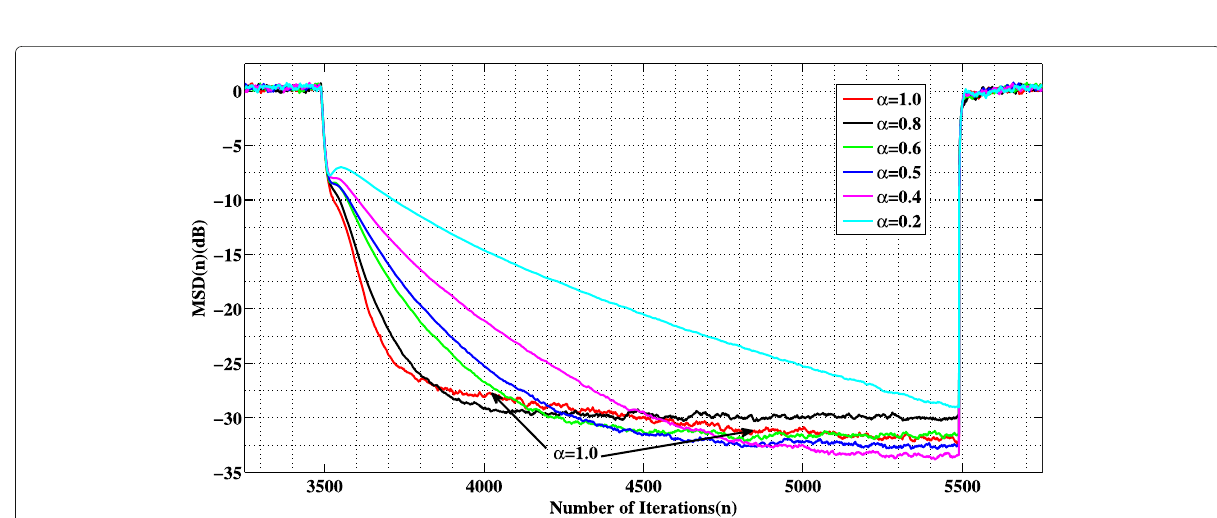
Fig. 17 Effect of coefficient transfer term on the MSD performance of the D-CFLF scheme when input signal is white noise